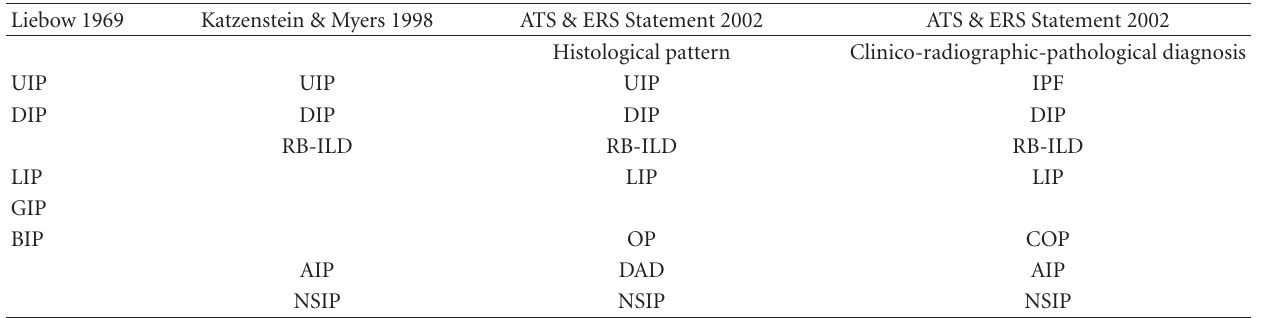
Table 1: Classifications of interstitial pneumonias.